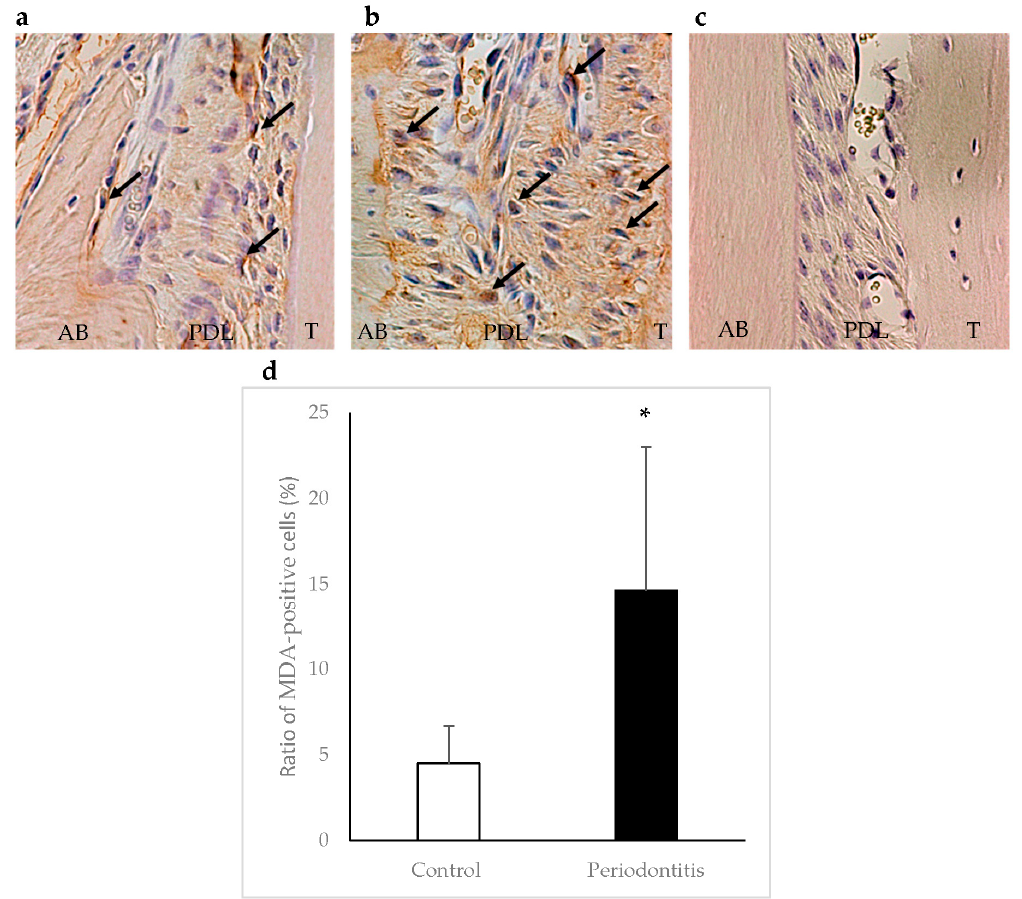
Figure 6. Immunohistochemical staining of malondialdehyde (MDA) in periodontal tissue at day 7. Arrows show MDA-positive cells. A higher number of MDA-positive cells was observed in areas adjacent to the alveolar bone surface within the periodontal ligament in the periodontitis group ( b ) than in the control group ( a ) (×400). Panel ( c ) shows a negative control. The ratio of MDA-positive cells was significantly higher in the periodontitisgroup than in the control group (* p < 0.01, t -test) ( n = 6/group) ( d ). AB, alveolar bone; PDL, periodontal ligament; T, tooth.